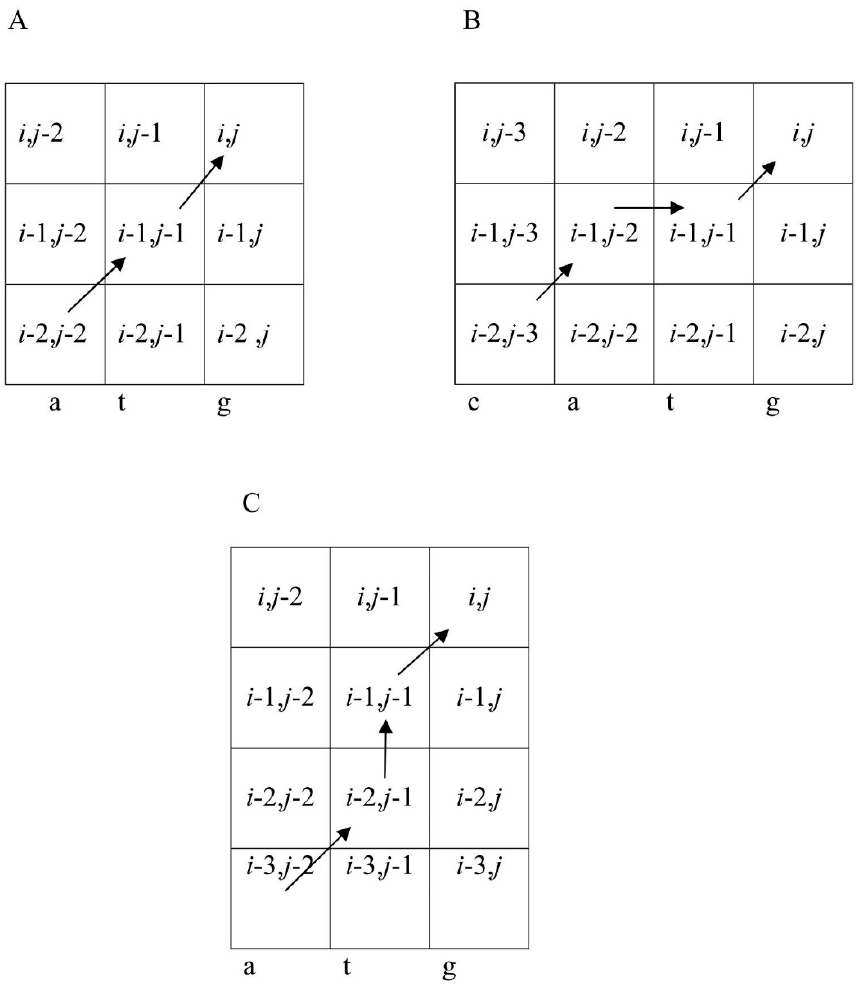
Figure 3. Three variants of the path from ( i − 1, j − 1) to ( i , j ) to calculate F ( i , j ) using Formula (5) when t < 3. ( A ) The transition to ( i − 1, j − 1) is from ( i − 2, j − 2). Then, the previous position in the alignment is ( i − 1, j − 1), which corresponds to t = 1. In this case, a pair of bases s ( j − 1) = t and s ( j ) = g